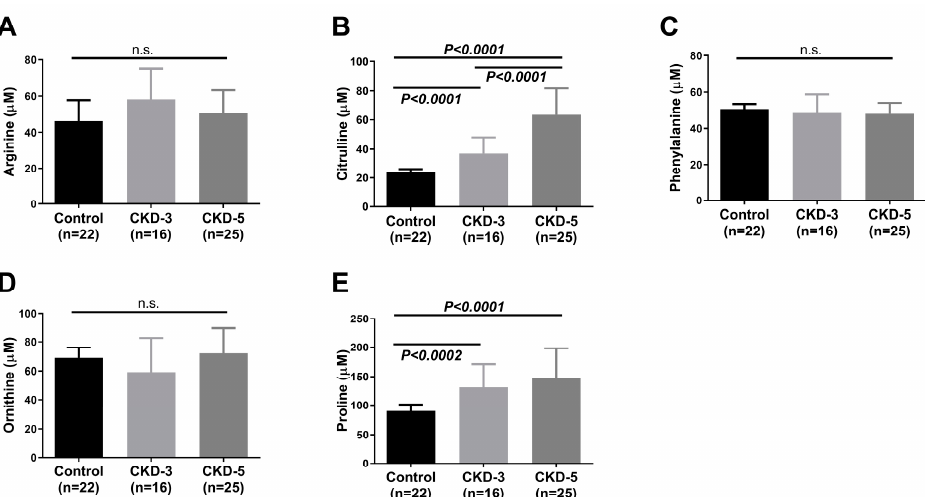
Figure 3. Plasma concentration of amino acids. Arginine ( A ), citrulline ( B ), phenylalanine ( C ), ornithine ( D ) and proline ( E ) between control (n = 22), CKD-3 (n = 16) and CKD-5 (n = 25) groups, respectively. Data are expressed as median (interquartile range); significances were assessed by Mann–Whitney U-test: for citrulline, p < 0.0001 between control vs. CKD-3 vs. CKD-5; for proline, p < 0.0001 between control vs. CKD-5 and p < 0.0002 between control vs. CKD-3. The concentration of arginine, citrulline, phenylalanine, ornithine and proline were measured using chromatographic separation. CKD-3 = chronic kidney disease stage 3; CKD-5 = chronic kidney disease stage 5. n.s.: no significance.